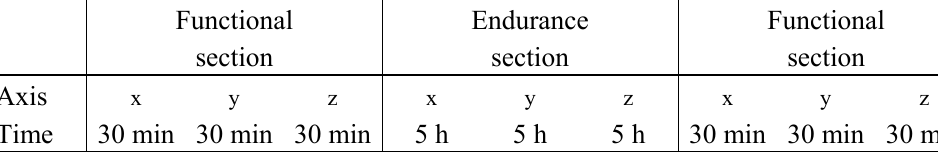
Table 3. Test plan for the dynamic excitation.